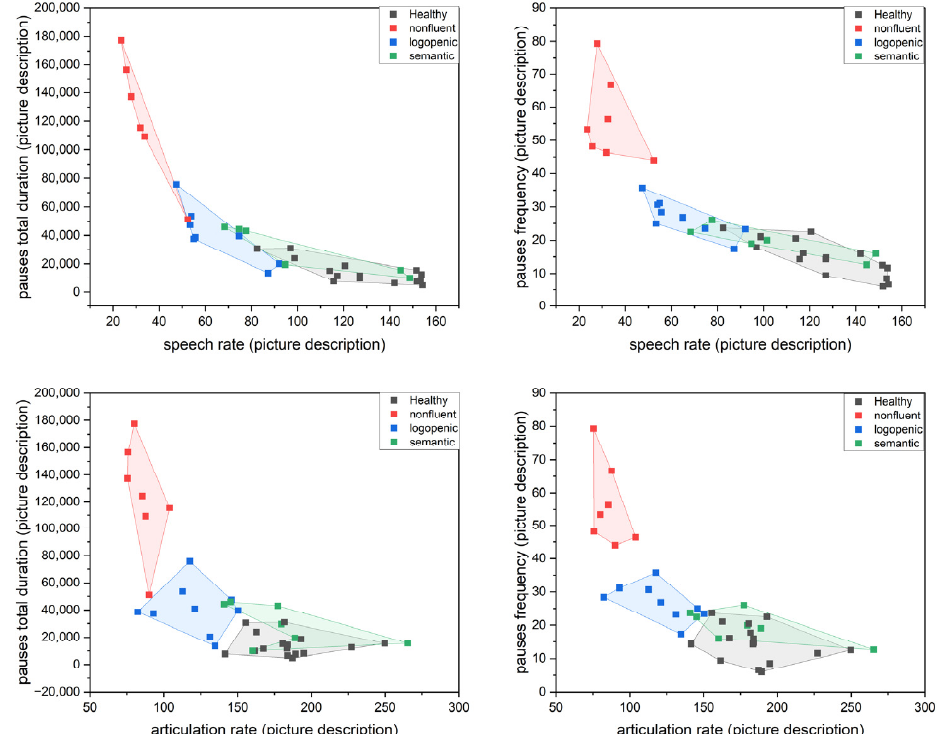
Figure 5. Scatter plots with convex hull ellipse depicting pause attributes versus speech attributes for the picture description task.